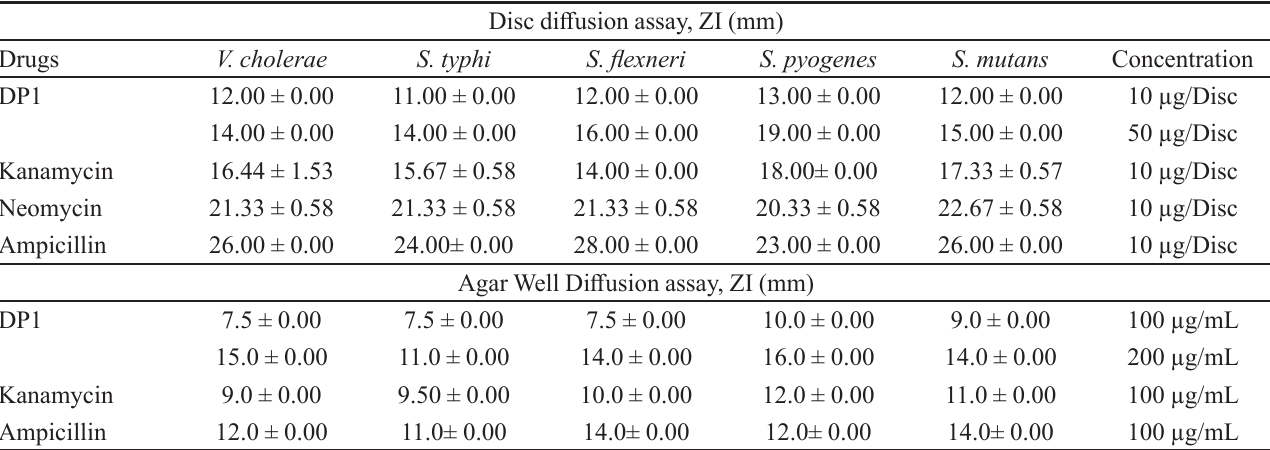
TABLE III - Antimicrobial activity (zone of inhibition) of fraction (DP1; RF: 0.82) of D. pentaphylla tuber